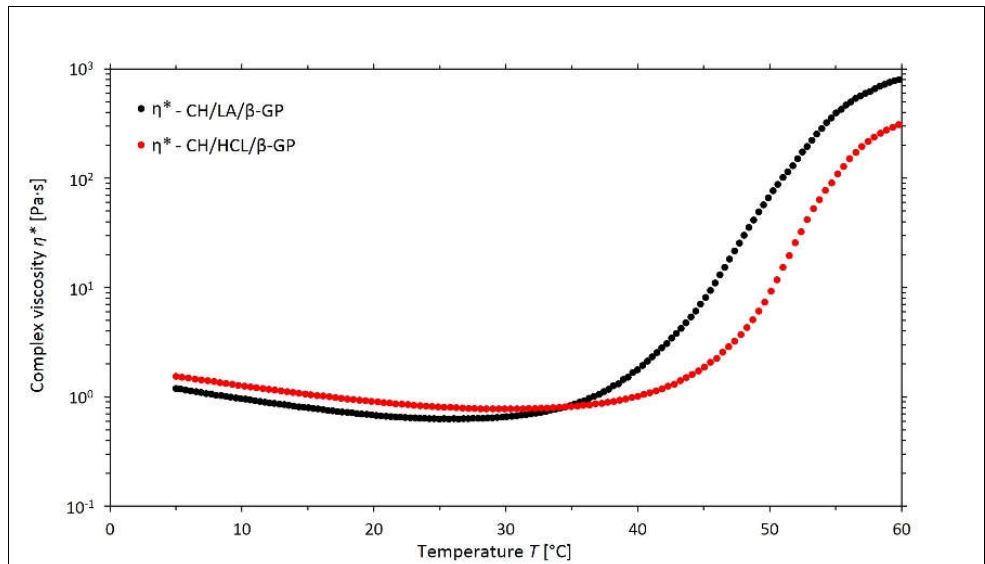
Figure 3. The experimental curves of the changes in the values of the complex viscosity η* as a function of the temperature T obtained for the chitosan lactate solutions (the CH/LA/β-GP system) and chitosan chloride (the CH/HCL/β-GP system) with β-glycerol phosphate disodium salt pentahydrate (β-GP).